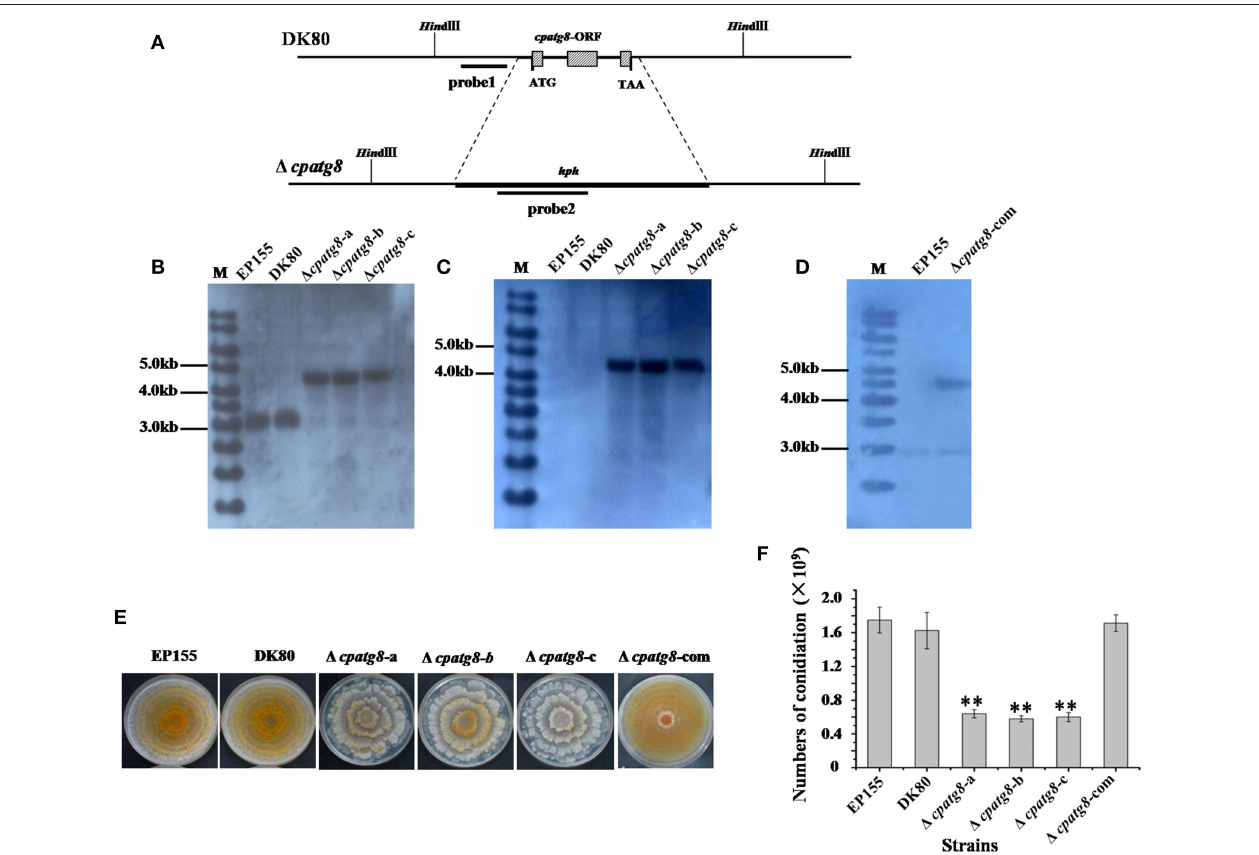
FIGURE 4 | Phenotypes and Southern analysis of cpatg8 knockout mutants. (A) Diagram of cpatg8 gene replacement strategy; probe fragment on the left arm was used in the Southern blot analysis to distinguish the fragment size of the wild-type strain and cpatg8 null mutants; Southern analysis of the cpatg8 null mutants (B,C) and complementary strain (D) . Fungal total DNAs were digested with Hind III and separated on a 0.8% agarose gel by electrophoresis, and blotted using probe 1 (B) and probe 2 (C) , respectively. Fragment sizes are indicated in the figure margins. (E) Mutant colony morphologies on PDA plates. Fungal strains were cultured on the laboratory bench top condition at 24 ◦ C, and the photograph was taken on day 14 postinoculation. (F) Sporulation level of cpatg8 knockout mutants. Spores were counted on day 14. Values are means ± S.E.M of three independent experiments. ** indicates P < 0.01, determined by Student’s t -test.